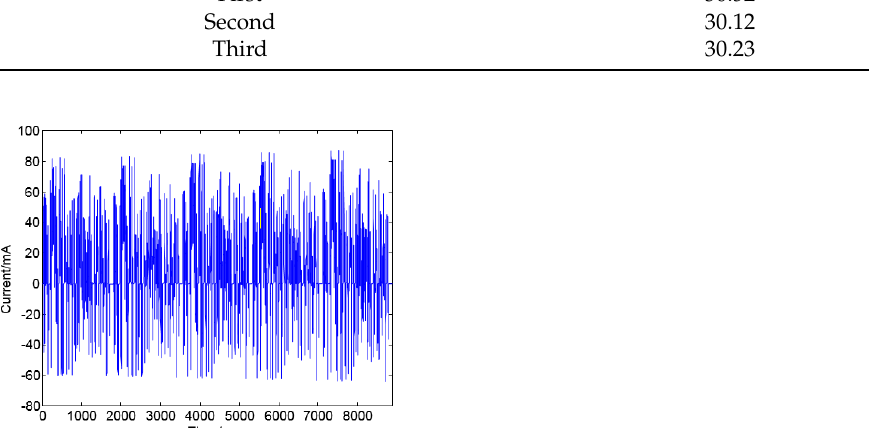
Figure 8. Current profiles of the battery for the Urban Dynamometer Driving Schedule (UDDS)